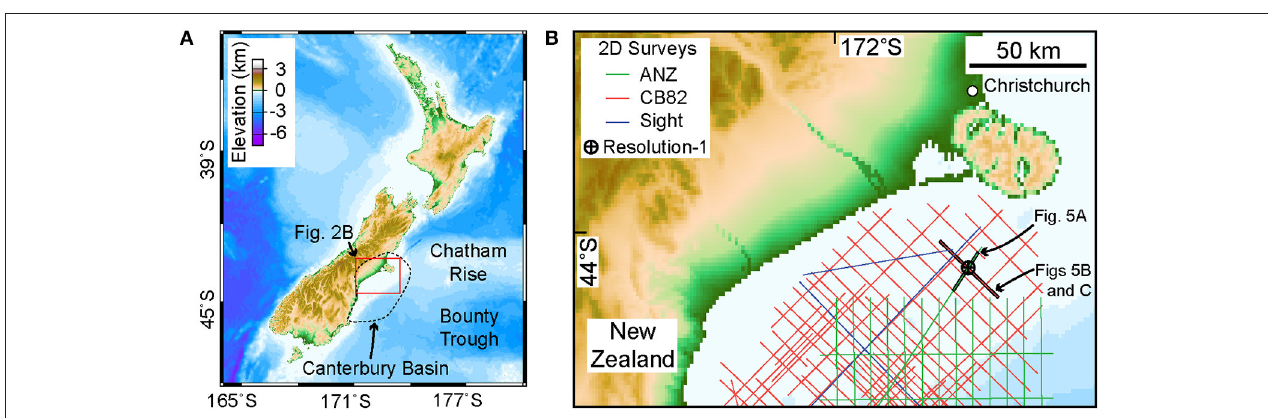
FIGURE 2 | (A) Location of the Canterbury Basin within New Zealand. (B) Location of 2D seismic lines and the Resolution-1 borehole used in this study.